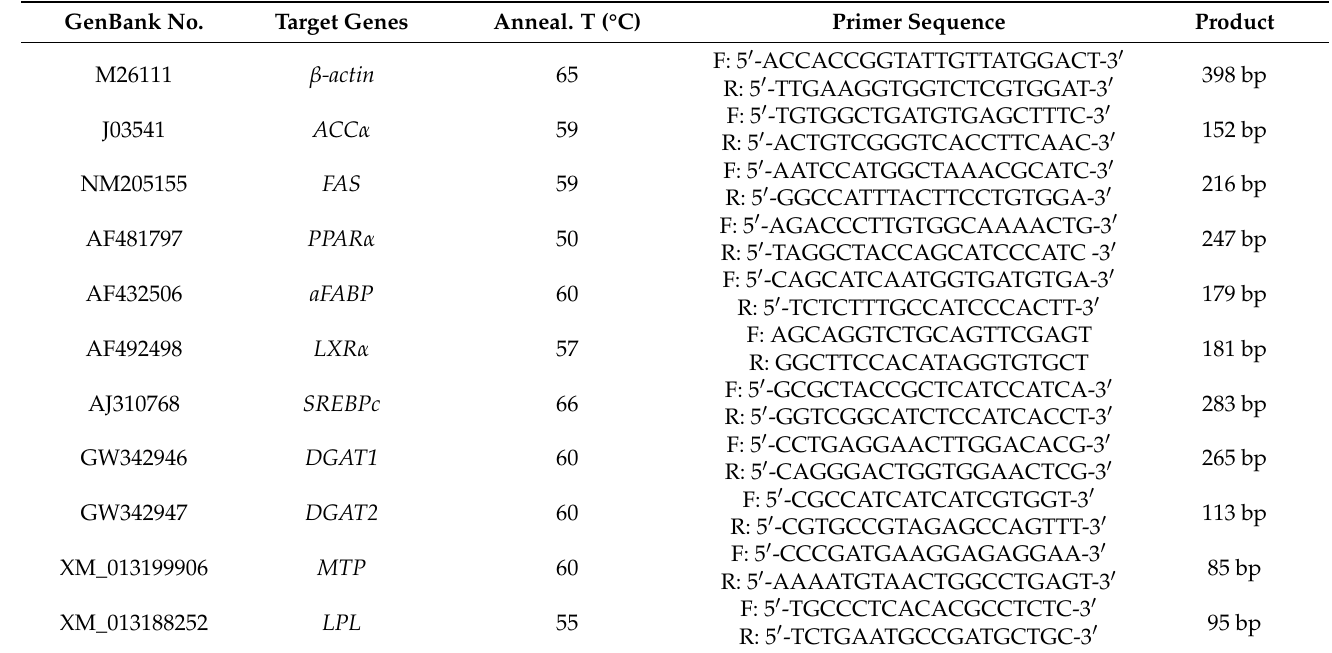
Table 1. Parameters of oligo-nucleotide primer pairs for the